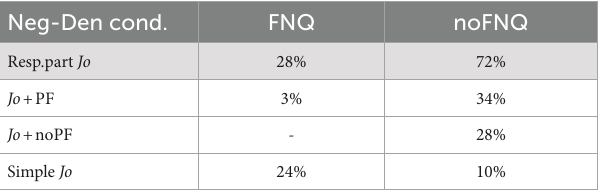
TABLE 3 Productions of sentence-initial response particle jo in the Neg- Den condition ( N = 29). Neg-Den